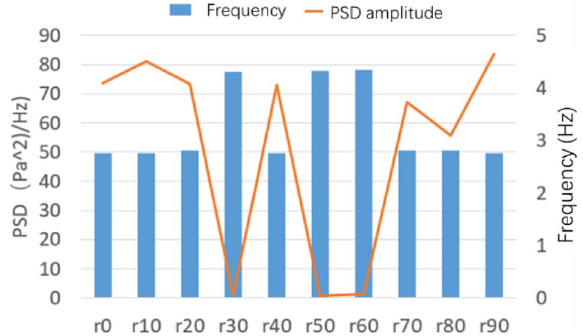
Figure 35. PSD coefficient of duty radio of spoiler.